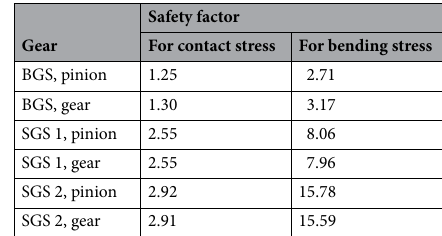
Table 12. Gear safety factor of modified gearbox in LDD after micro-geometry modification.